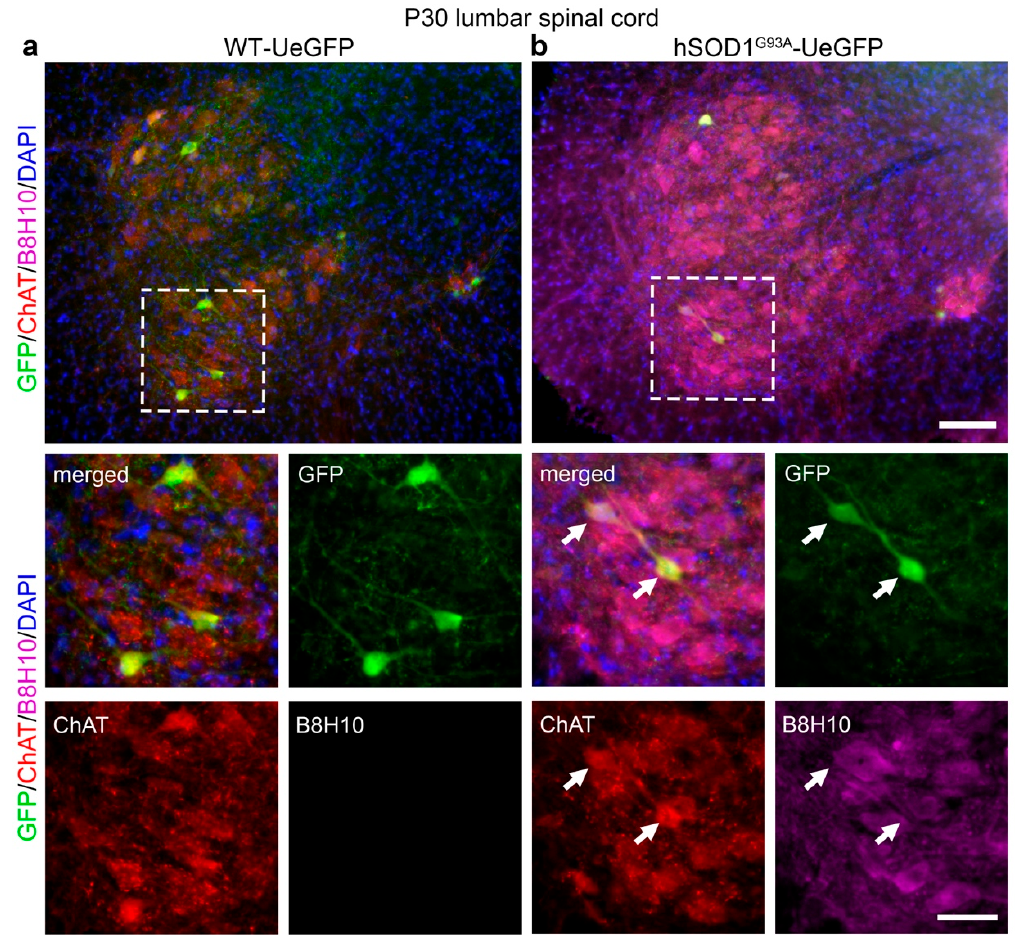
Figure 3. Misfolded SOD1 protein in the ventral horn of the lumbar spinal cord. ( a ) No B8H10 signal is detected in the spinal cord of WT-UeGFP control mice; ( b ) misfolded SOD1 protein can be detected in the lumbar spinal cord of hSOD1 G93A -UeGFP mice by the B8H10 antibody in ChAT + SMN. Arrows point to eGFP + ChAT + SMN without a misfolded SOD1 signal. Boxed areas enlarged in the panels below. Scale bar, 100 µ m (top, low mag) and 50 µ m (bottom, high mag).